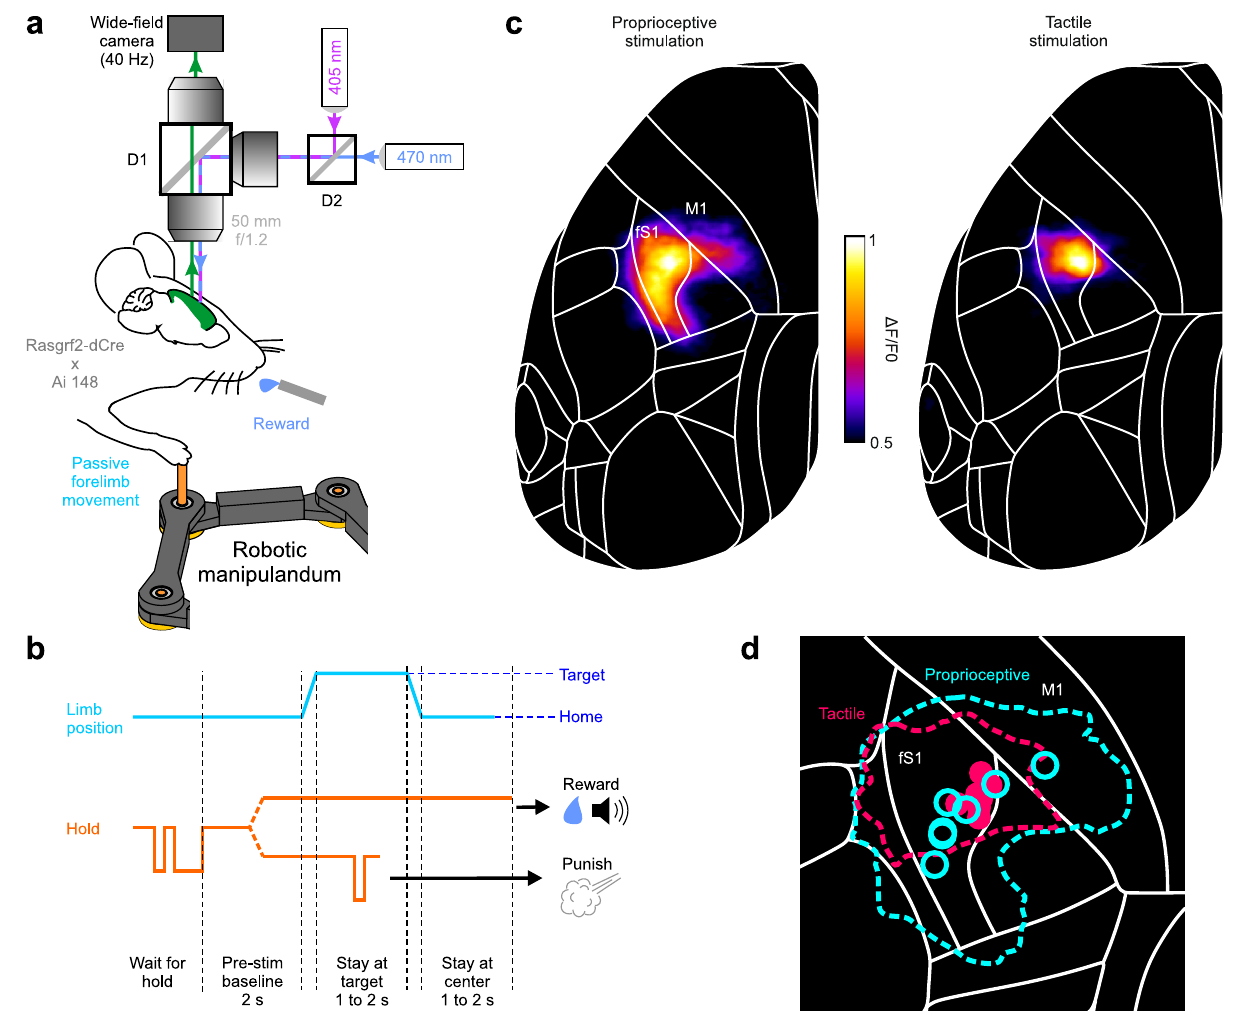
Fig. 2 | Cortex-wide imaging of neural activity during proprioceptive stimula- tion of the mouse forelimb. a Schematic of the macroscope (D1, D2: dichroic mirrors) for wide- fi eld imaging of Ca2+ dependent cortical activity in Rasgrf2-dCre; Ai148 mice during passive forelimb displacements with a robotic manipulandum. b Trial timeline of the passive forelimb displacement task (split dotted lines denote